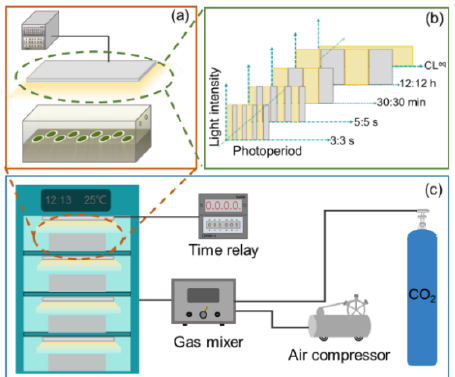
Figure 1. Schematic of experimental setup. ( a ) Microalgae biofilm cultivated in a bioreactor. ( b ) The photoperiods were set to 3:3 s, 5:5 s, 30:30 min, 12:12 h (light-period-to-dark-period ratio), and